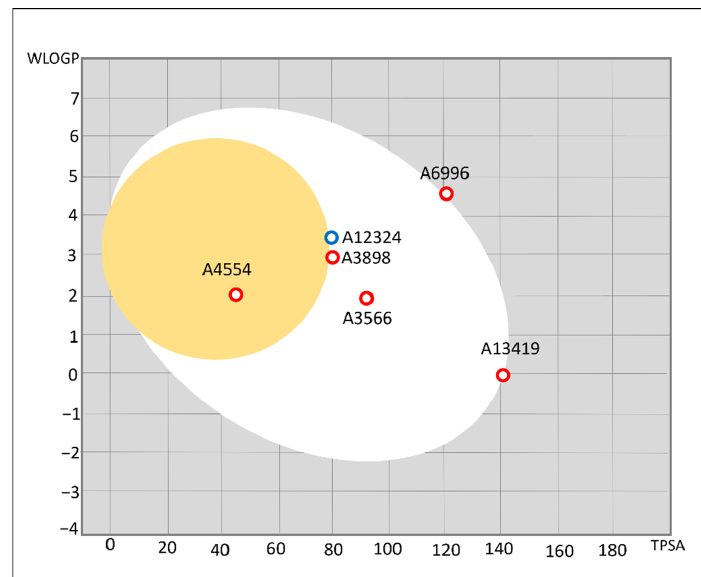
Figure 4. Predicted human intestinal (HIA), and P-glycoprotein efflux (P-gp) inhibition of the se-